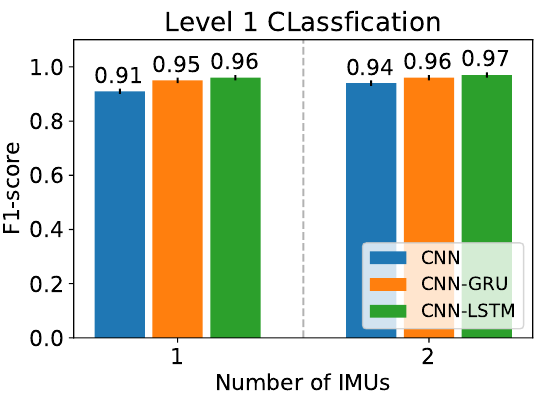
Figure 8. F 1-score of the different network architectures for one and two IMUs for the classification task of level 1.